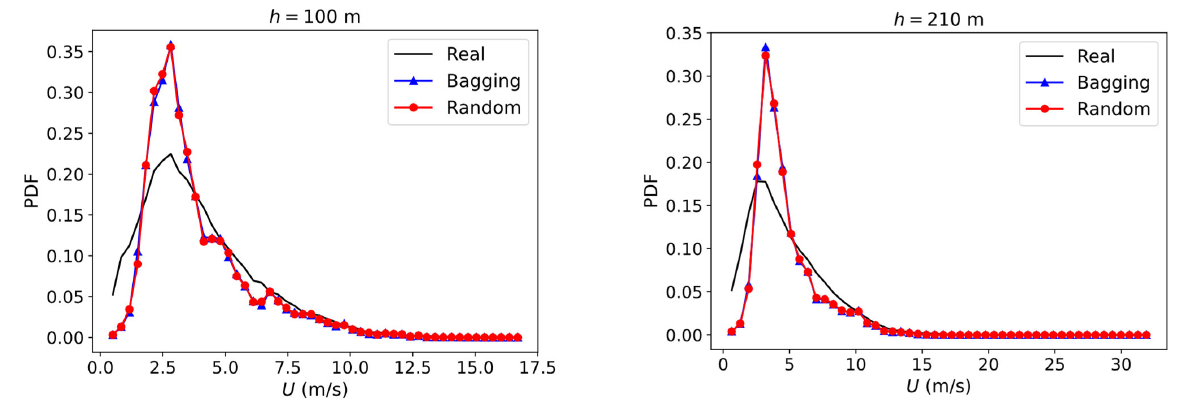
Figure 5. Comparison between measured and actual wind speed distribution. Table 4. Statistical variables for the distributions at ℎ (cid:3404) 210 m for both the bagging and random forest regressors.